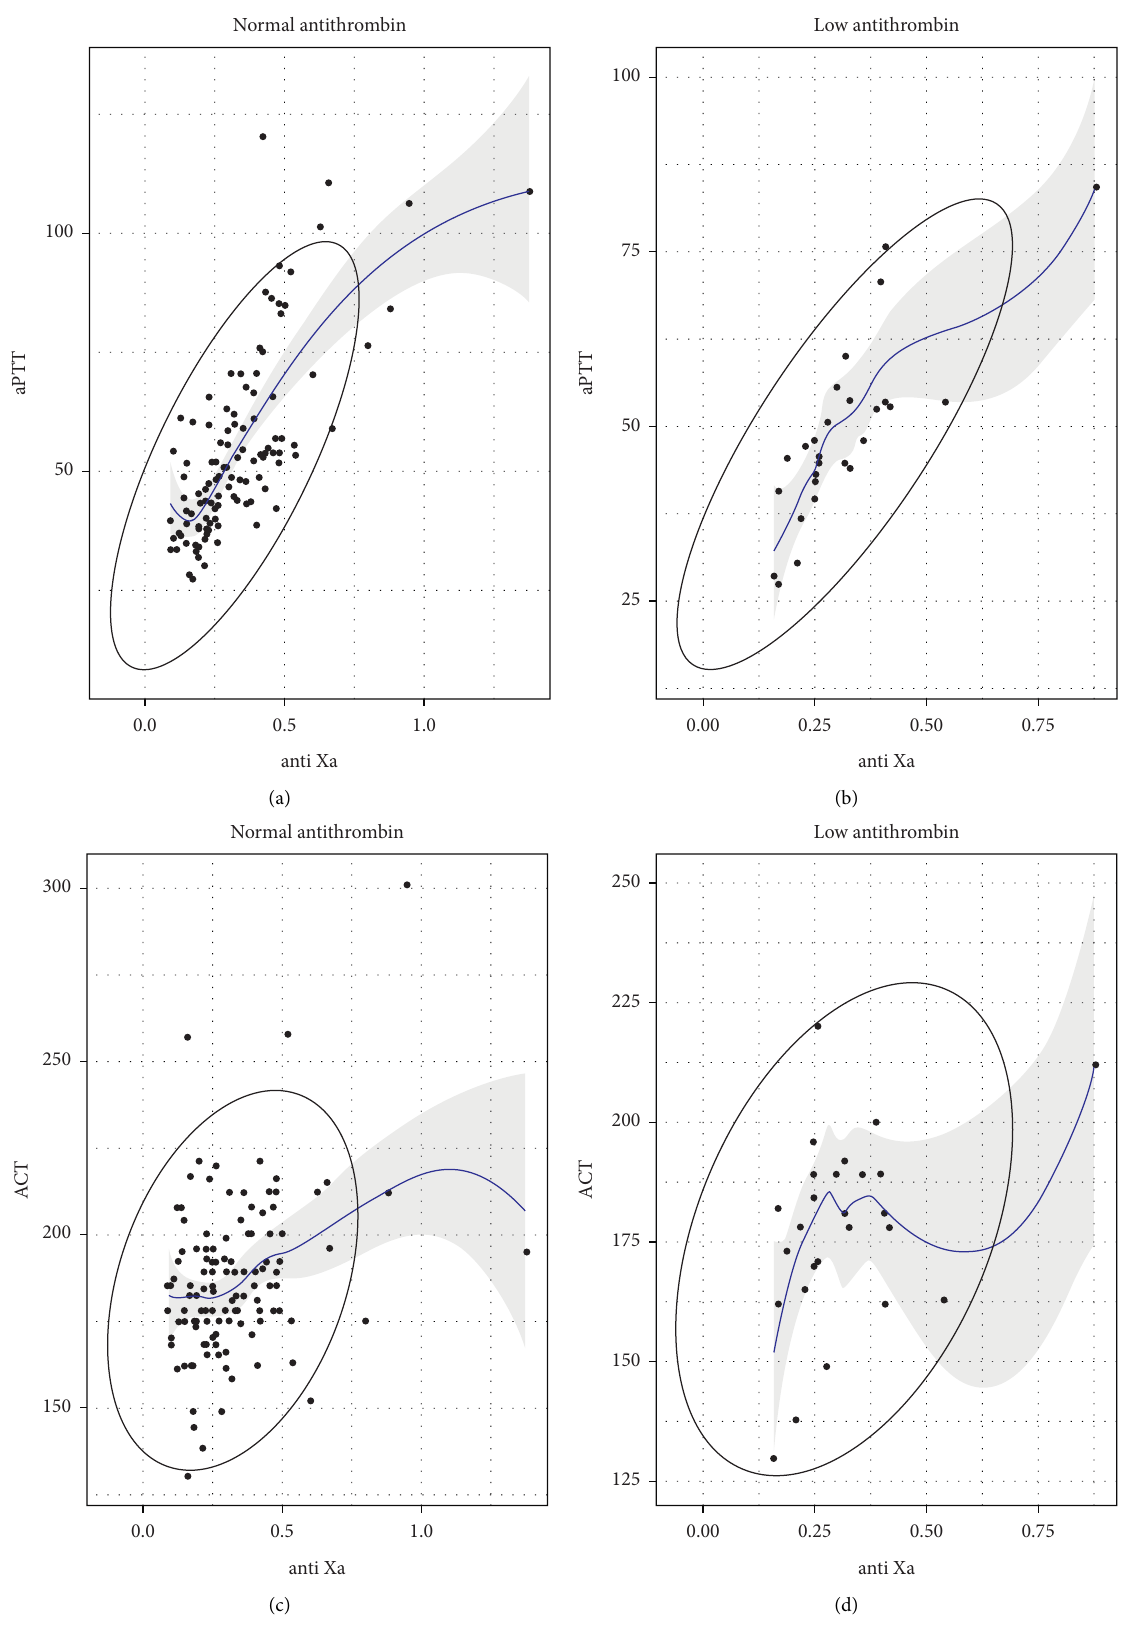
Figure 1: Scatter plot showing correlation between APTT, ACT, and